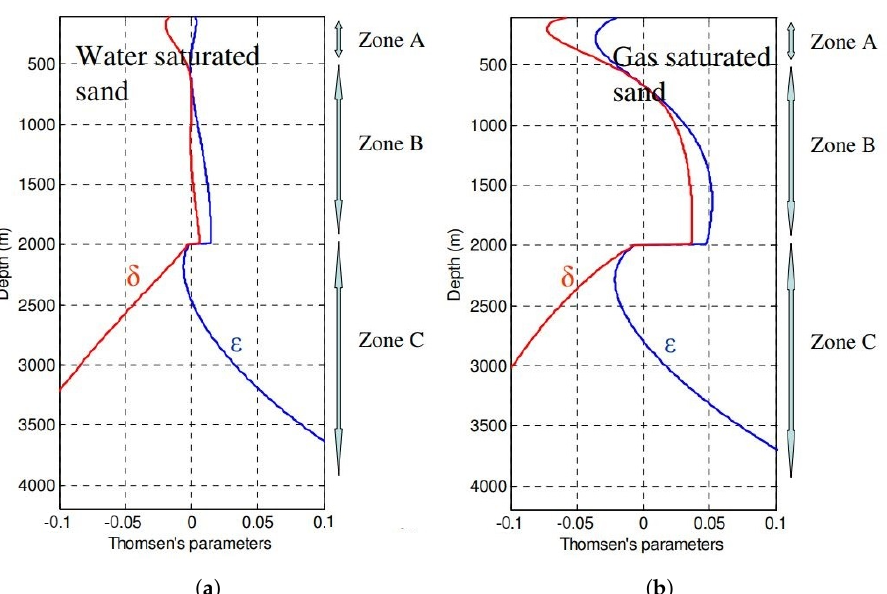
Figure 24. Plots of the anisotropy parameters, Epsilon (blue curve) and Delta (red curve), on the X- axes versus the depth on the Y-axes, for both the water- and gas-saturated sand ( a and b , respectively). The depth range is divided into three zones, (A), (B), and (C), which are the shallow, compaction, and diagenesis regimes, respectively